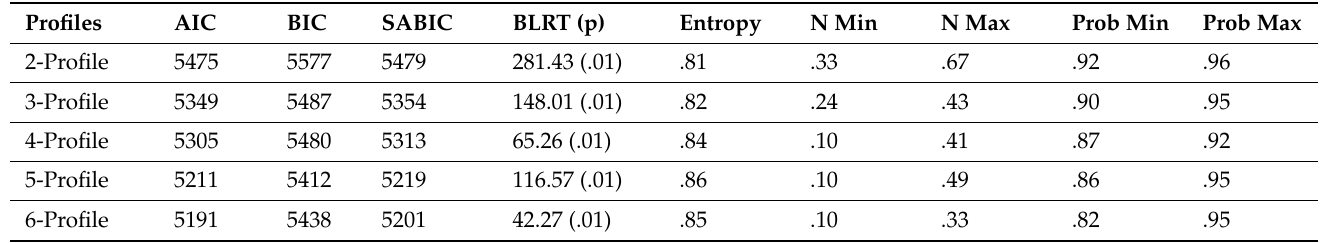
Table 5. Model fit indices, class size, and class probabilities for FFM–AMPD Combined latent